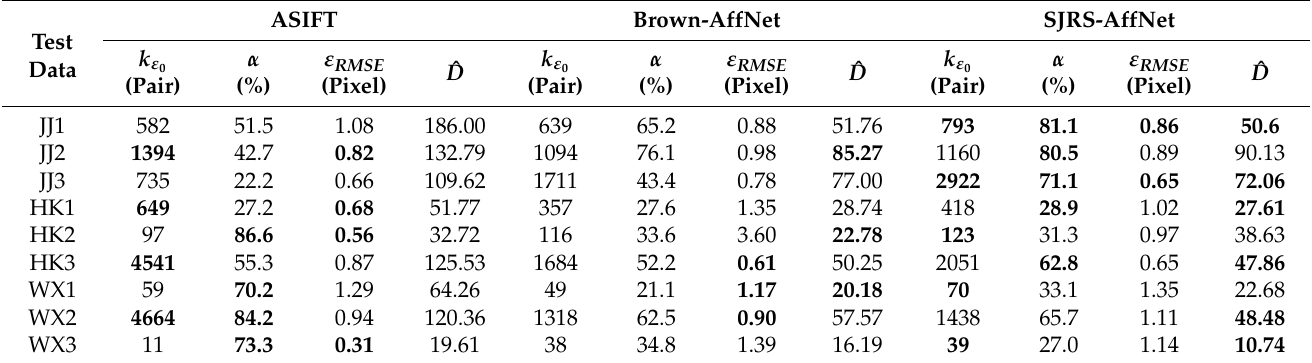
Figure 13. Delaunay triangulation network of matches from satellite stereo images WX1–3. ( a , d , g ) tested on ASIFT. ( b , e , h ) tested on Brown-AffNet. ( c , f , i ) tested on SJRS-AffNet. Table 1. Comparison of the test results of three methods using ground-based, aerial, and satellite images. The best values are highlighted in